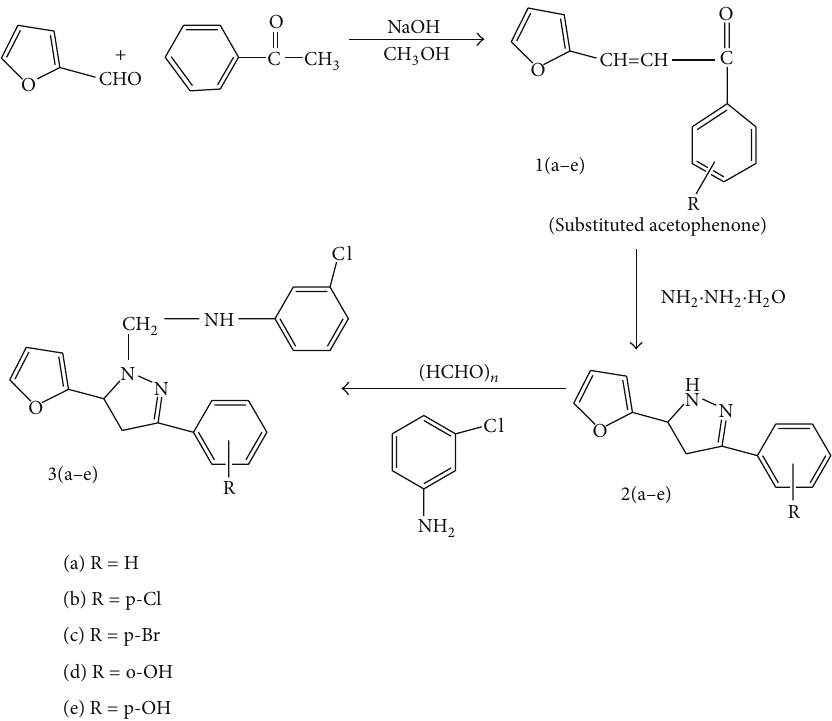
Figure 1: Scheme for synthesis of compounds 3(a–e).